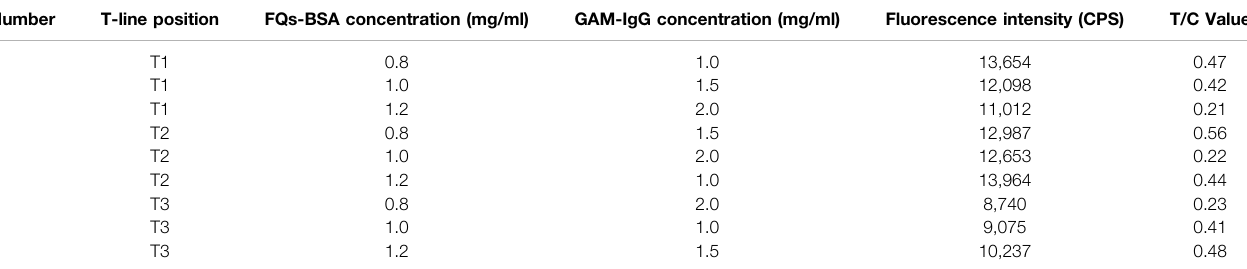
TABLE 2 | Orthogonal test to analyse the results of optimisation of L9 (3) 3 on FQs-BSA concentration, GAM-IgG concentration and paddle